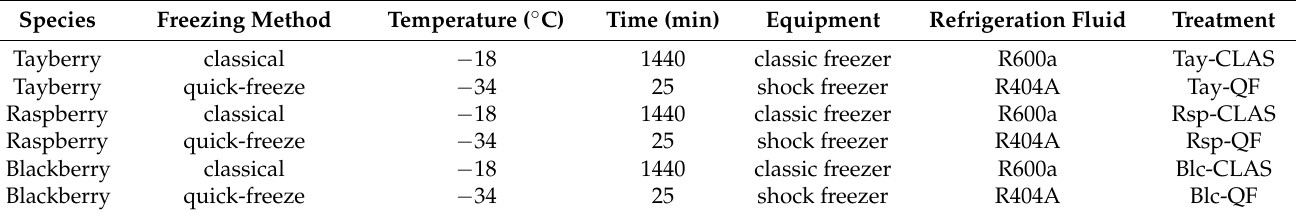
Table 1. The experimental plan for fruit-freezing of different berry